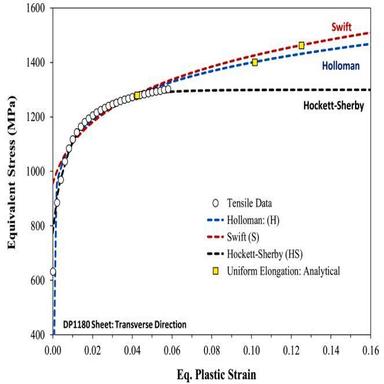
Comparison of several hardening models and the predicted uniform elongation for a DP1180 steel. The hardening model parameters were determined using least squares minimization. The experimental uniform elongation occurred at a plastic strain of 0.057 or applied true strain of 0.063.